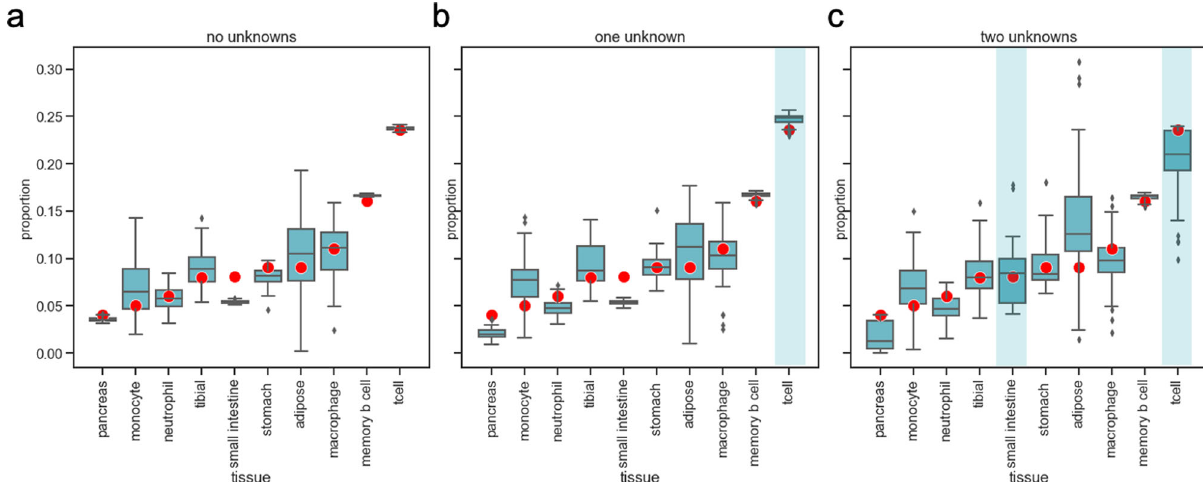
Fig. 5 CelFiE cell type proportion estimates for a randomly selected individual ’ s real WGBS cfDNA over 50 simulation experiments. The blue boxes represent estimates of the true cell type composition (red dots) for 100 individuals in 50 simulation experiments in the scenario where there are no missing cell types ( a ), when CD4 + T cells are a missing cell type (indicated by blue shading) ( b ) and when CD4 + T cell and small intestine are both missing ( c ). The center line of the boxplot indicates the mean, the outer edges of the box indicate the upper and lower quartiles, and the whiskers indicate the maxima and minima of the distribution.